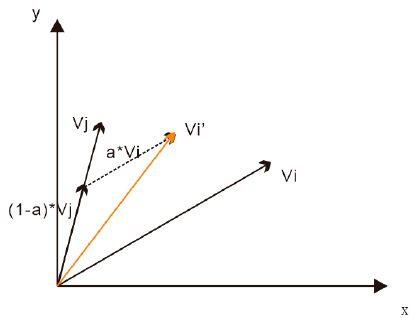
Figure 7. The crossed velocity is depicted by the orange vector.